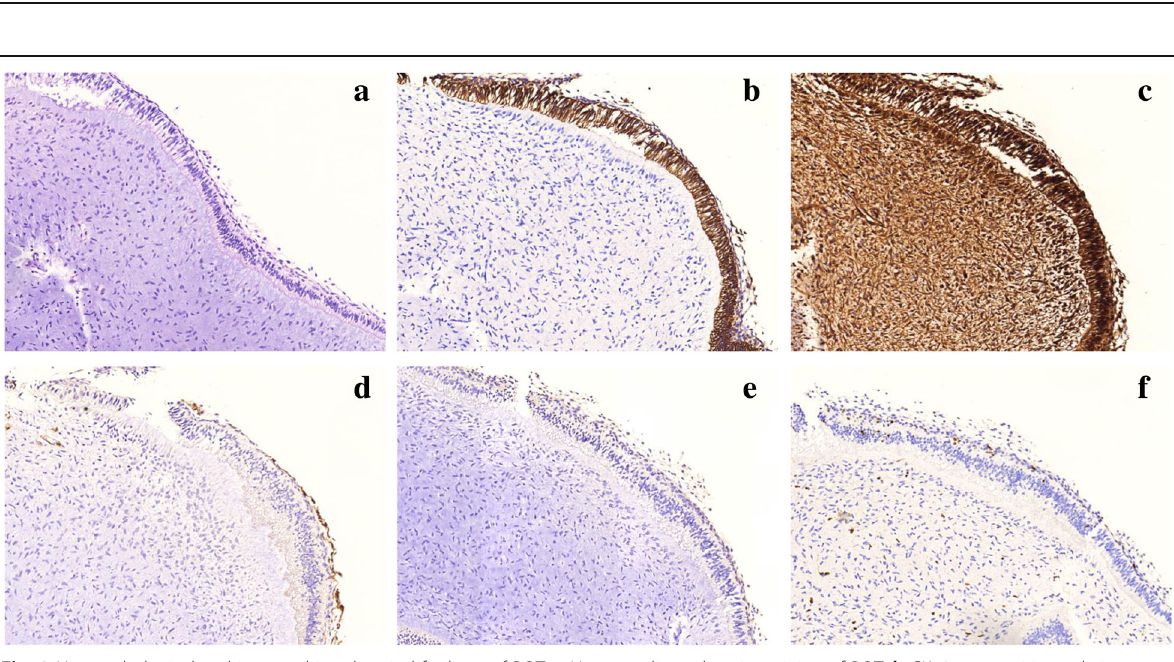
Fig. 3 Histopathological and immunohistochemical findings of POT. a Hematoxylin and eosin staining of POT. b CK19 was positive only in columnar epithelium. c Vimentin was positive throughout the tumor tissue (strongly positive in epithelial layers and moderately positive in mesenchymal tumor cells). d Ectomesenchymal cells were negative for α -SMA. e Ectomesenchymal cells were negative for S-100 protein. f Ki67 labeling index was basically lower than 2%. (magnification, ×